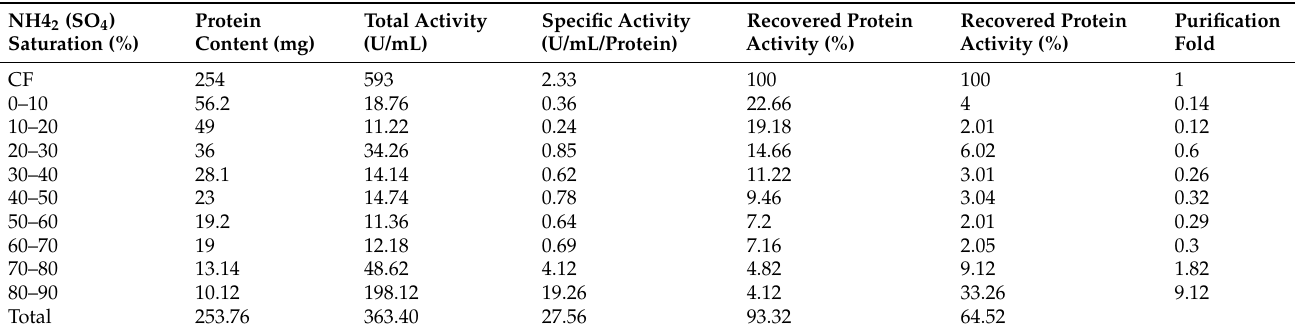
Table 2. Fractionated precipitation marine Staphylococcus aureus CASMTK1 hyaluronidase with ammonium